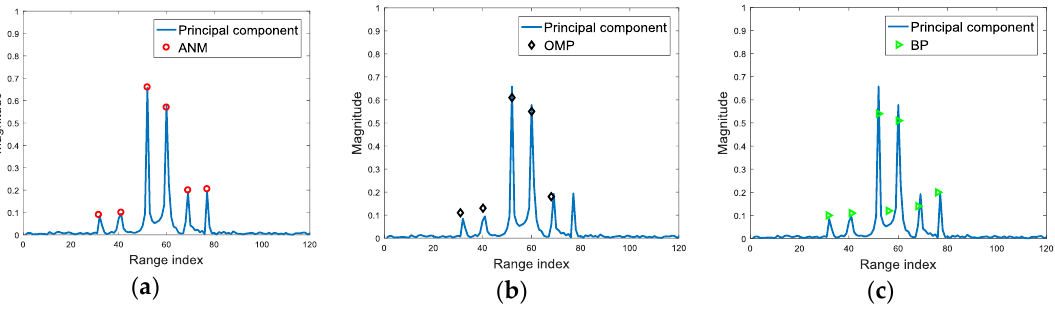
Figure 7. The scatterer extraction comparison for ANM, OMP and BP. ( a ) The scatterer extraction result via ANM; ( b ) The scatterer extraction result via OMP; ( c ) The scatterer extraction result via BP.